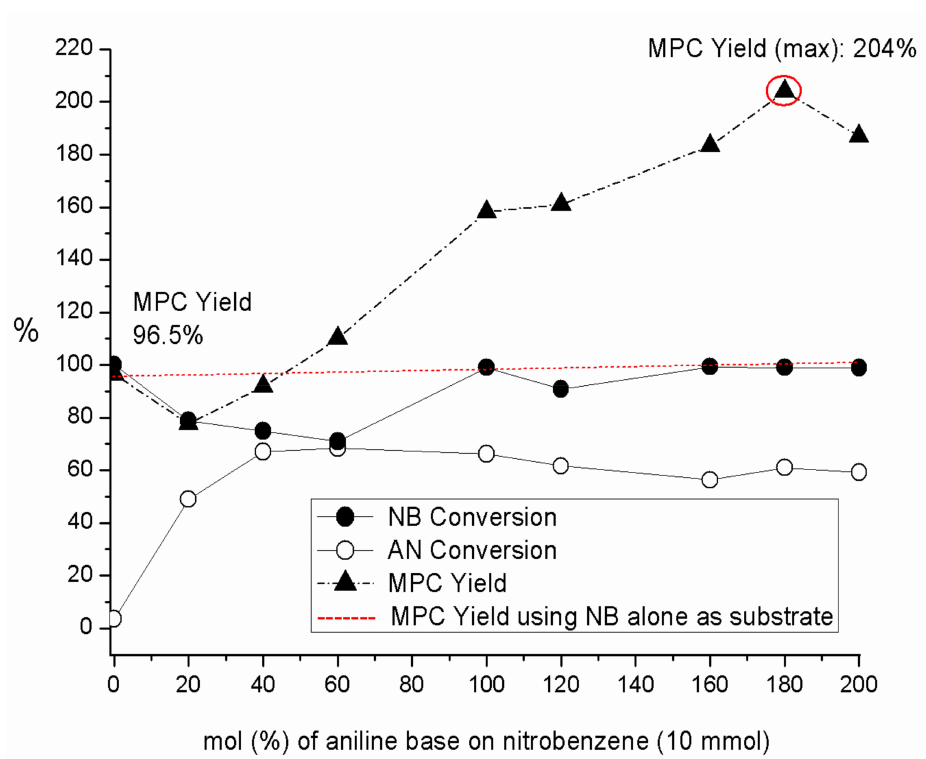
Figure 6. E ff ect of the addition of aniline on the activity of the reductive carbonylation of nitrobenzene. Conditions: NB (10 mmol), 5 wt% FeSe 2 / γ -Al 2 O 3 (0.5 g, [FeSe 2 ]: 0.1169 mmol), molar ratio of NB / FeSe 2 = 85, MeOH (30 mL), T = 160 ◦ C, p = 8.3 MPa of CO, t = 4